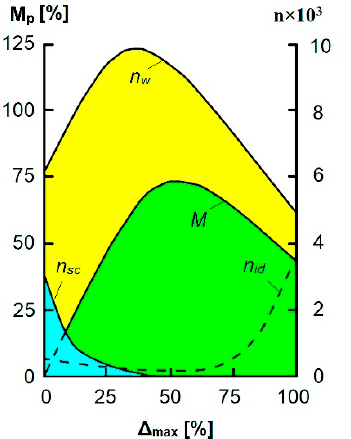
Figure 6. Dependence of the rate M p and the number of pulses n on the discharge gap Δ .